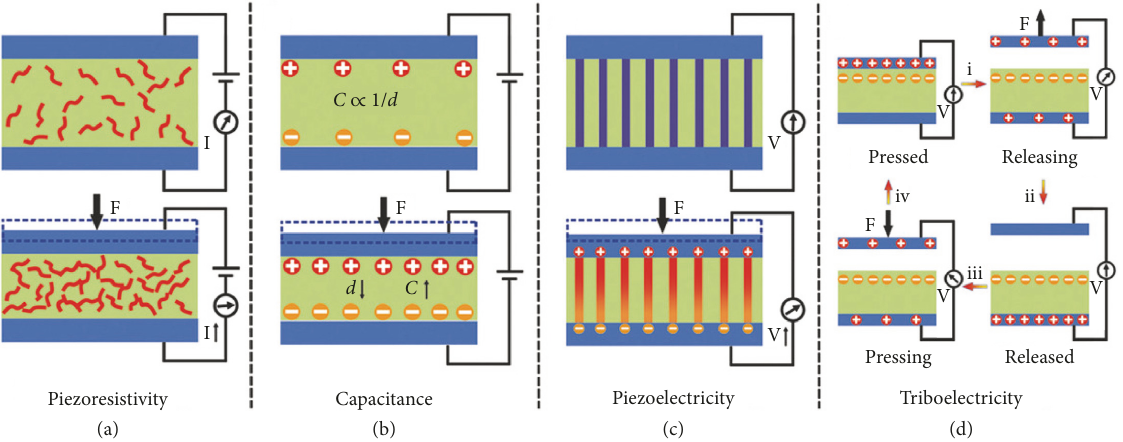
Figure 2: Schematic illustrations for four typical transduction mechanisms of tactile sensors: (a), piezoresistive, (b) piezocapacitive, (c) piezoelectric, and (d) triboelectric (adapted from Ref. [46], copyright (2018), with permission from WILEY-VCH publishing